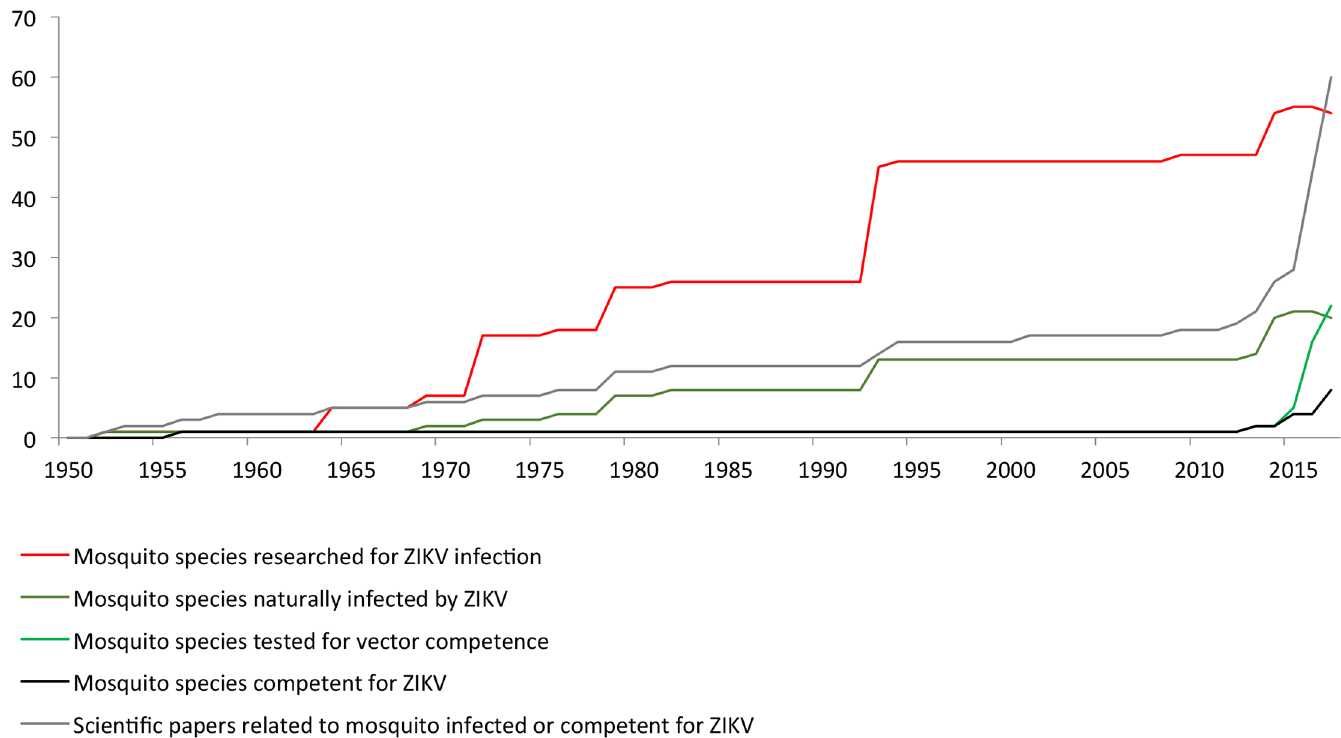
Fig 2. Synthesis of the research related to vector species of ZIKV between 1952 and March 15, 2017. Evolution of the numberof scientific papers related to vector species of ZIKV, the number of field species tested for the presenceof Zika, the numberof naturallyZIKV-infected species, the numberof species studiedexperimentally for their competence,and the number of species observedonce competent for ZIKV between1952 and March 15, 2017. ZIKV, Zika virus.